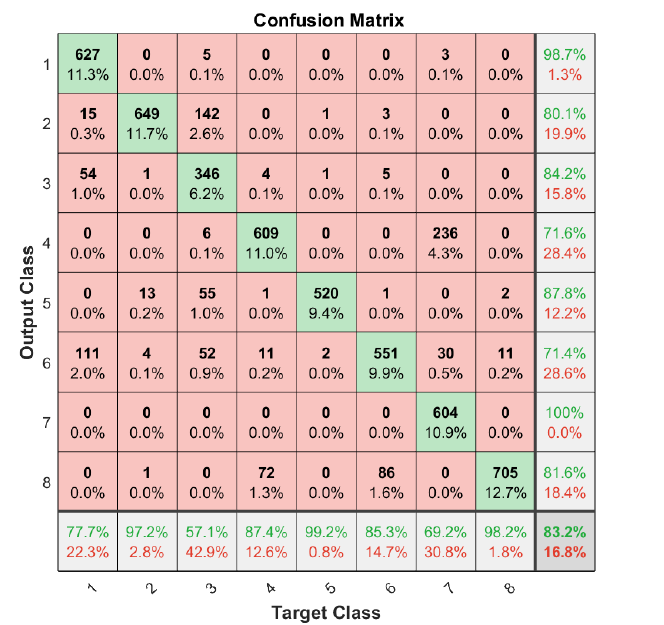
Figure 15. Confusion matrix generated using the LSTM algorithm.